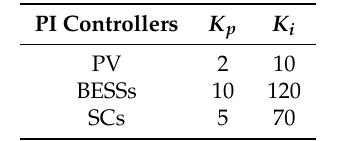
Table A1. Gain parameters of classic PI controllers.